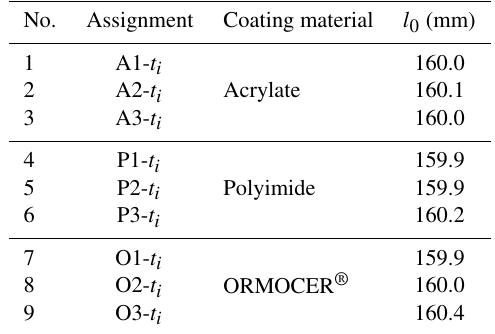
Table 3. Specimen assignment and coating material for the shrink- age